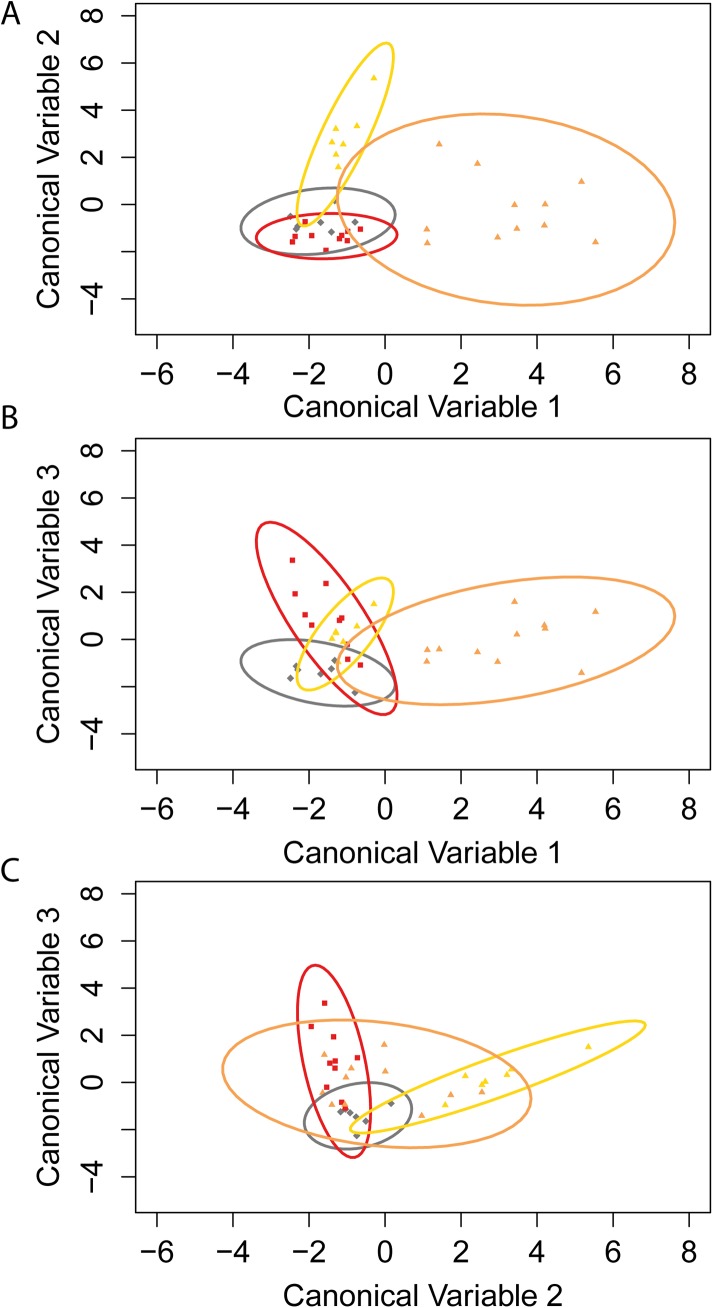
Discriminant function analysis (DFA) confirming the presence of four discrete throat colour morphs following testosterone implantation.Orange: red squares; orange+yellow: orange triangles; yellow: yellow triangles; and grey: grey diamonds. Individuals are plotted for canonical variables A) 1 and 2; B) 1 and 3; and C) 2 and 3, with 95% confidence ellipses.